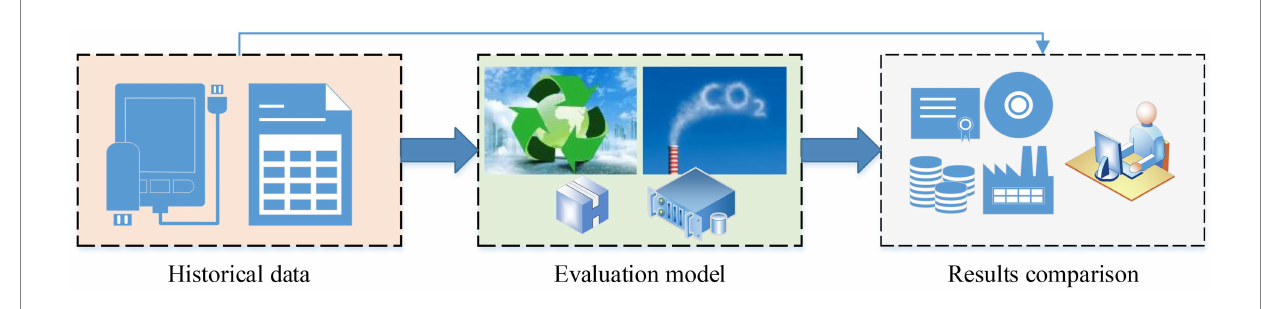
FIGURE 7 The framework for the economy dispatch application test.